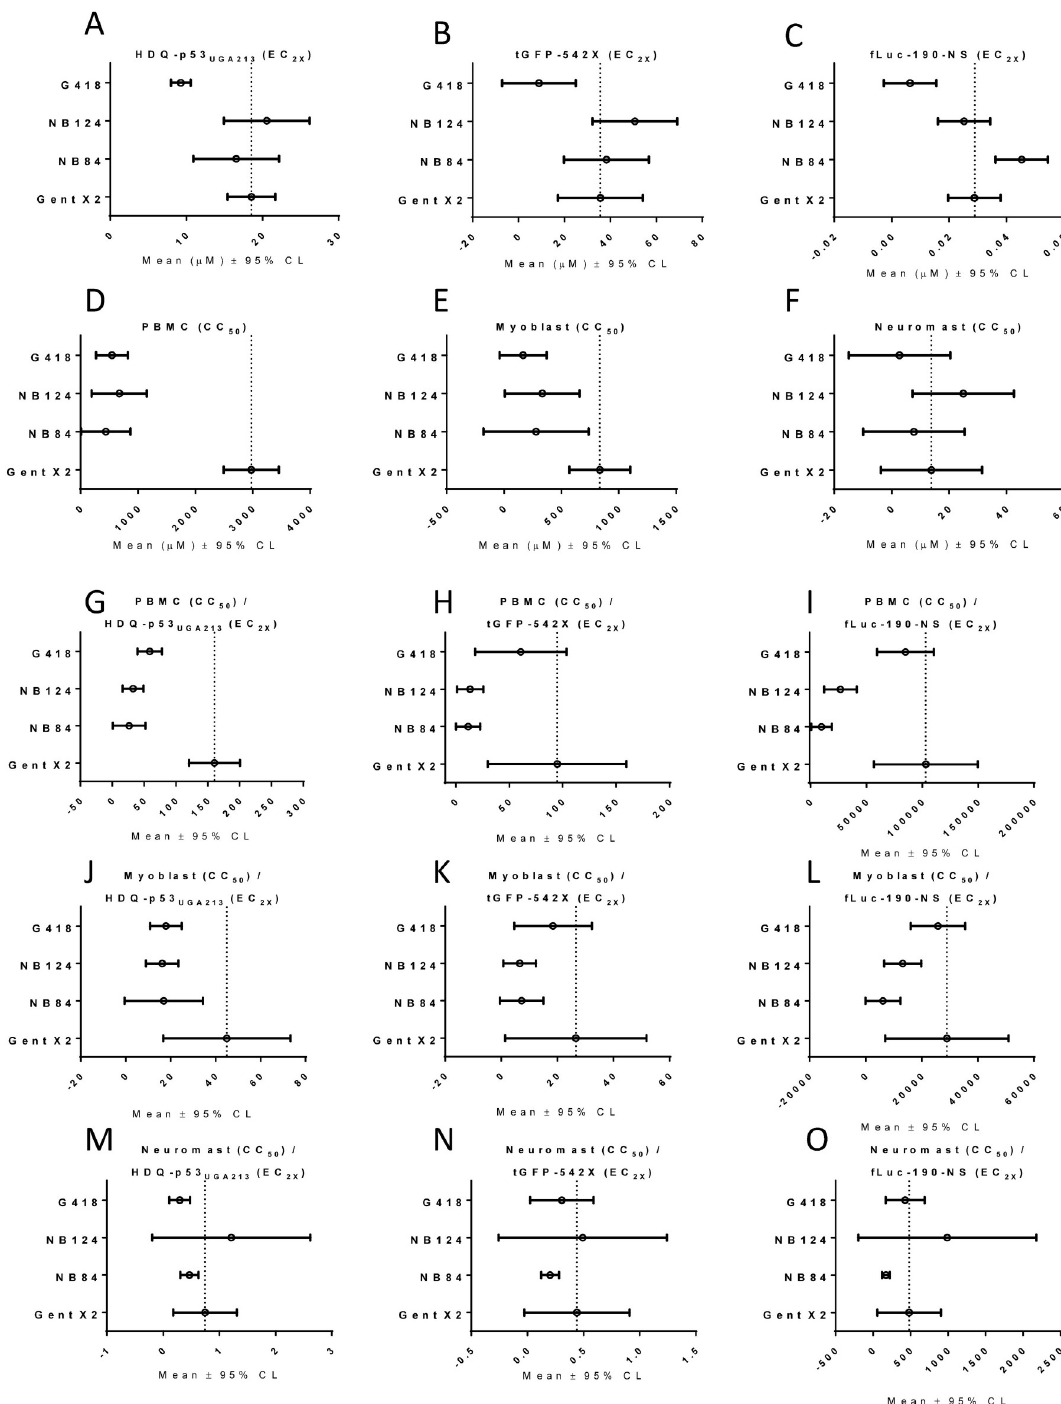
Fig 2. Statistical comparison of selected aminoglycosides. Graphs show average values for at least three independent experiments (open circles) for each aminoglycoside indicated on the y-axis. Error bars indicate the 95% confidence limits for each average. The title of each graph indicates the average measurement or the average calculated ratio. A-C are potency averages from the three readthrough assays; D-F are averages for the three cytotoxicity assays and G-O show the mean ratios between the readthrough and the cytotoxicity assays. All values used for calculating averages can be found in S1